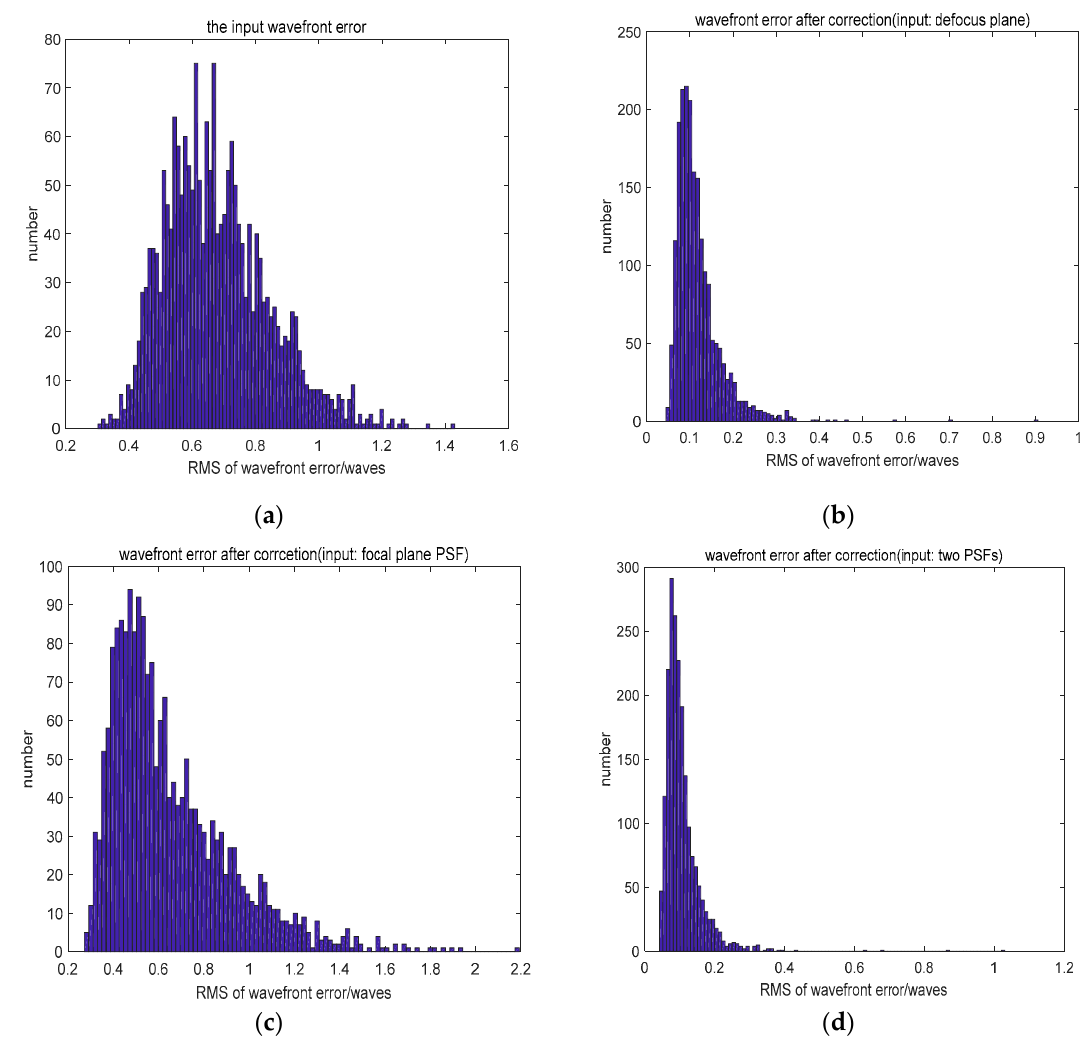
Figure 3. ( a ) The distribution of the input wavefront error and ( b – d ) the distribution of wavefront error after correction.